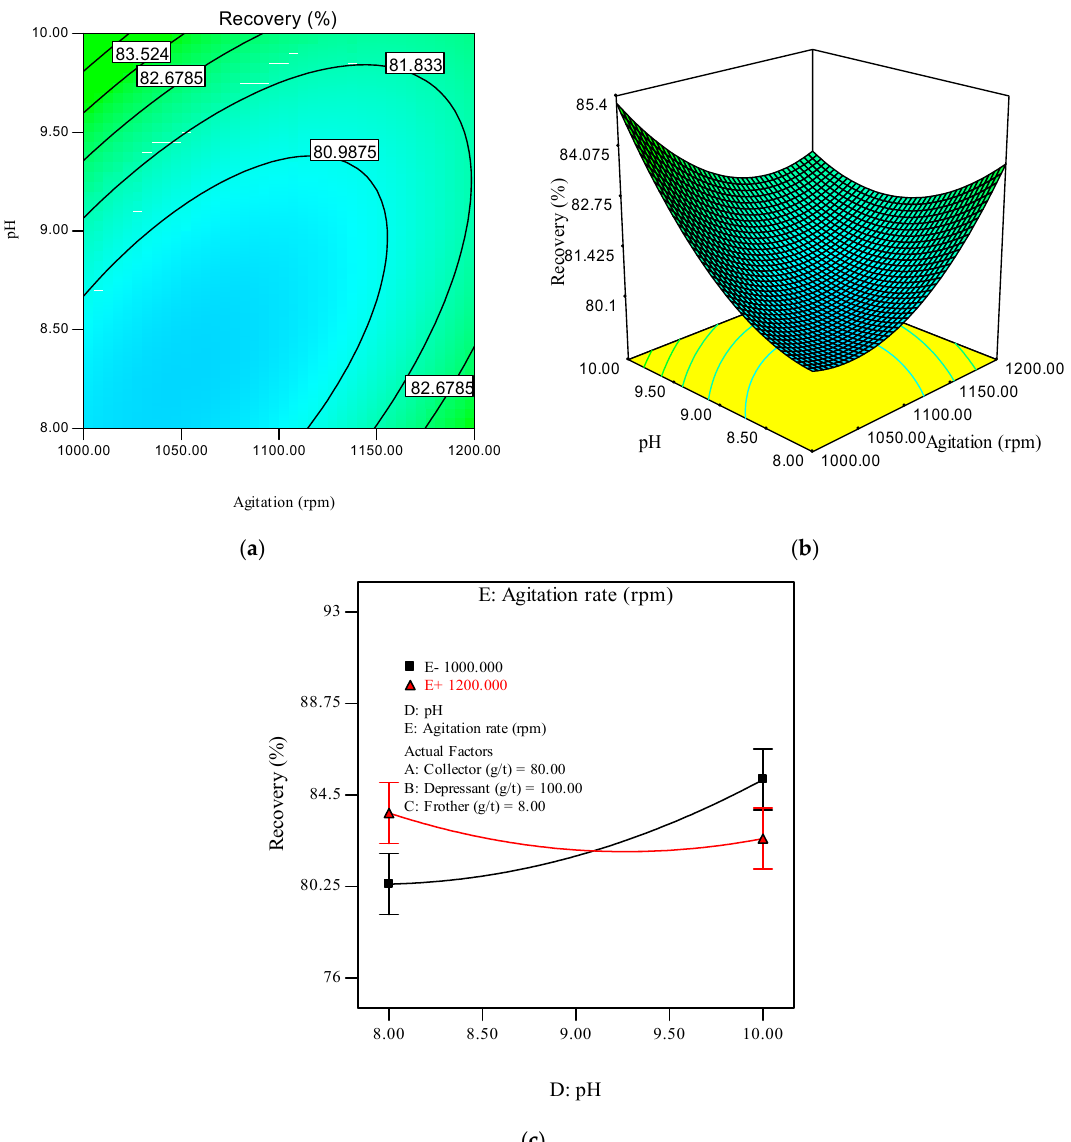
Figure 5. ( a ) Contour plot and ( b ) 3D response showing the combined effect of pH and agitation speed and ( c ) their interaction effect on the copper recovery.